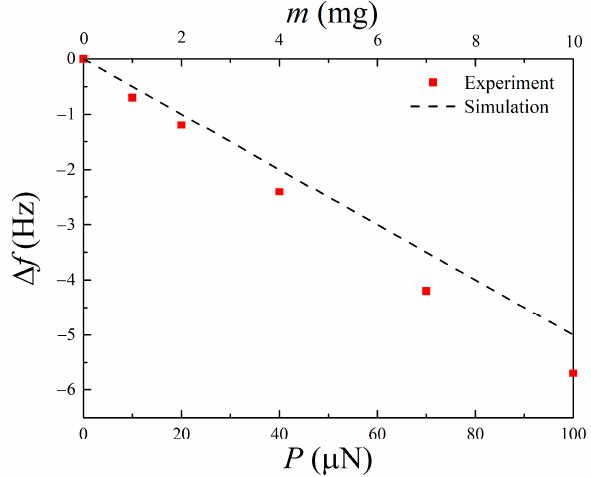
Figure 3. Measured output voltage versus frequency.